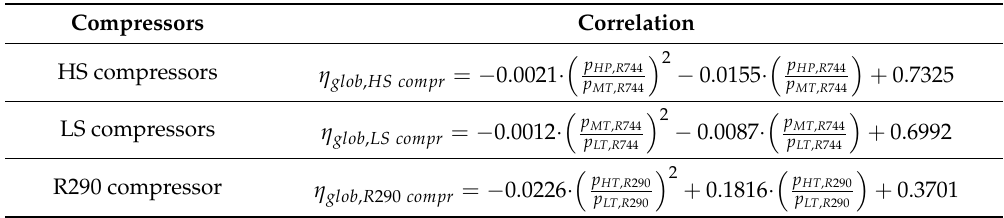
Table 5. Correlations employed for evaluating the global efficiency of the compressors belonging to the investigated solution